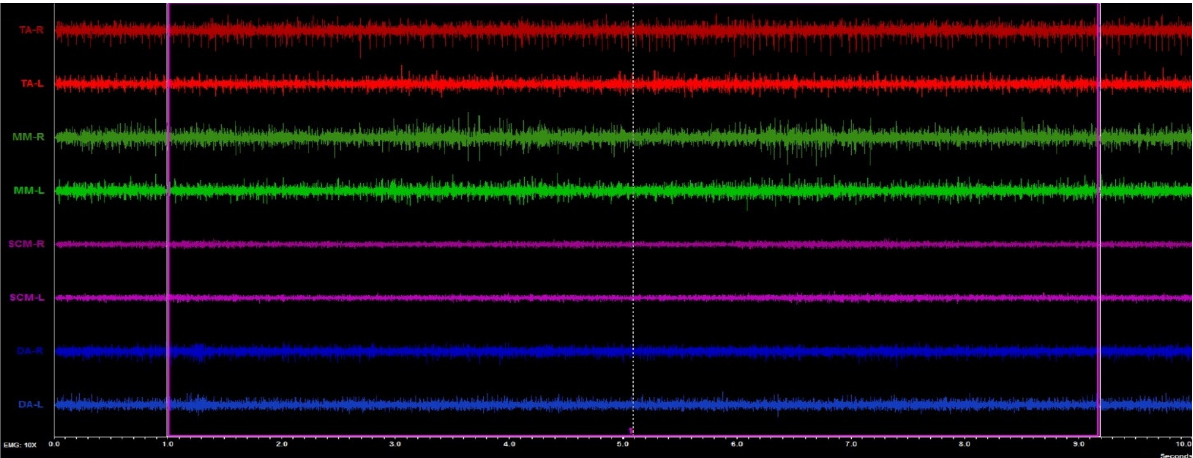
Figure 2. Example of the surface electromyography traces during resting activity.